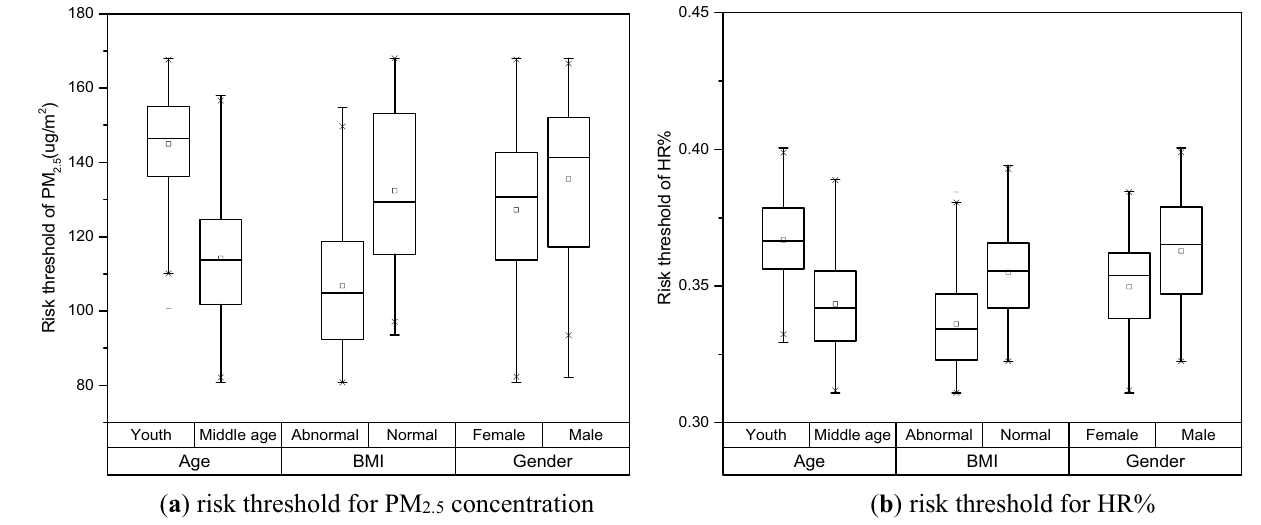
Figure 4. Distribution of health risk thresholds among volunteers.